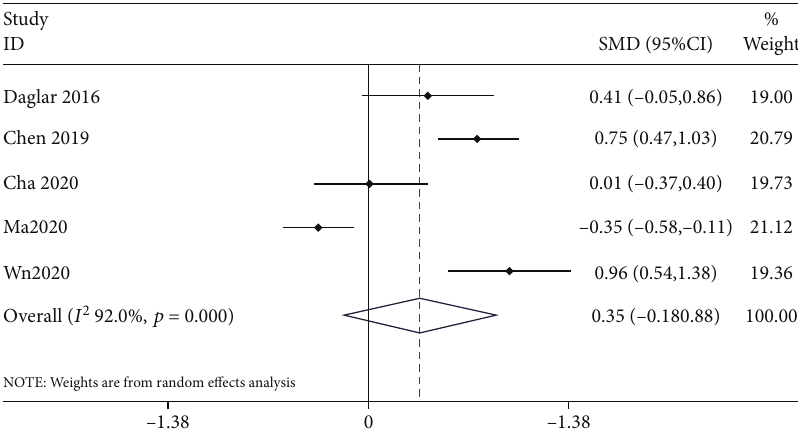
Figure 3: Forest plot of LMR levels in the spontaneous preterm birth group in comparison to the control